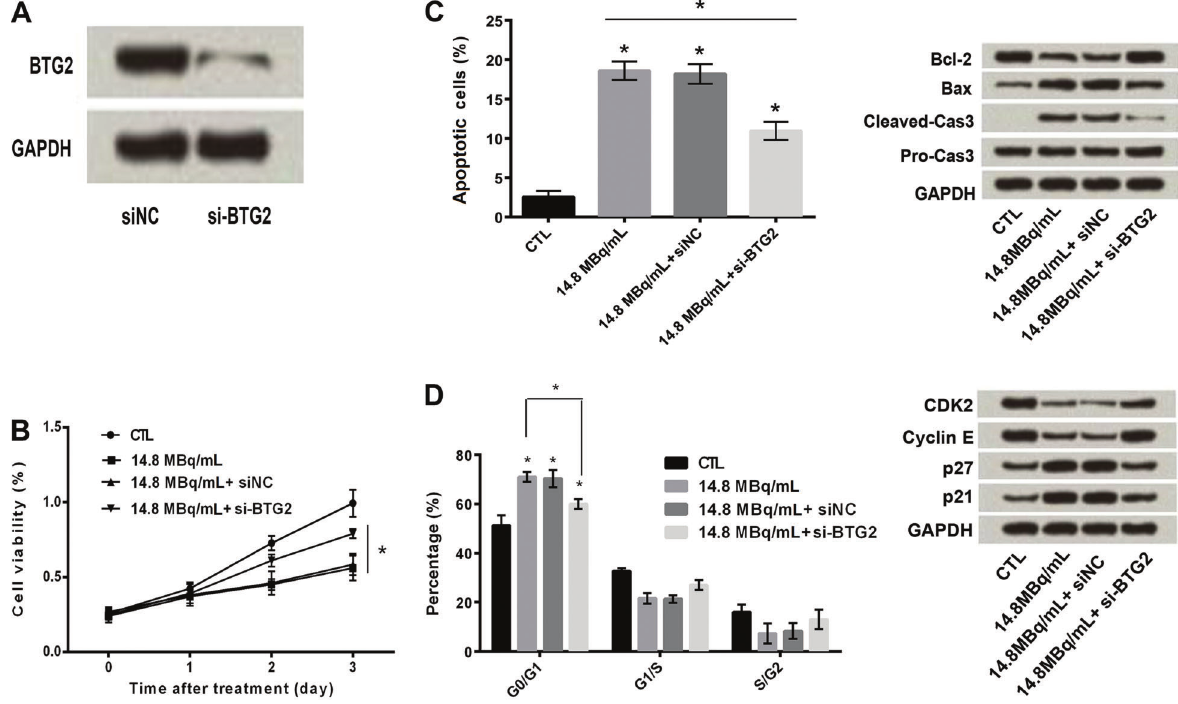
Figure 3. A , Transfection ef fi ciency of BTG2. Silencing of BTG2 increased iodine-131 ( 131 I)-induced cell proliferation ( B ), 131 I-induced cell apoptosis ( C ), and down-regulated 131 I-induced cell cycle arrest ( D ). Data are reported as means ± SD. *P o 0.05 compared with control (CTL – GAPDH) (ANOVA).